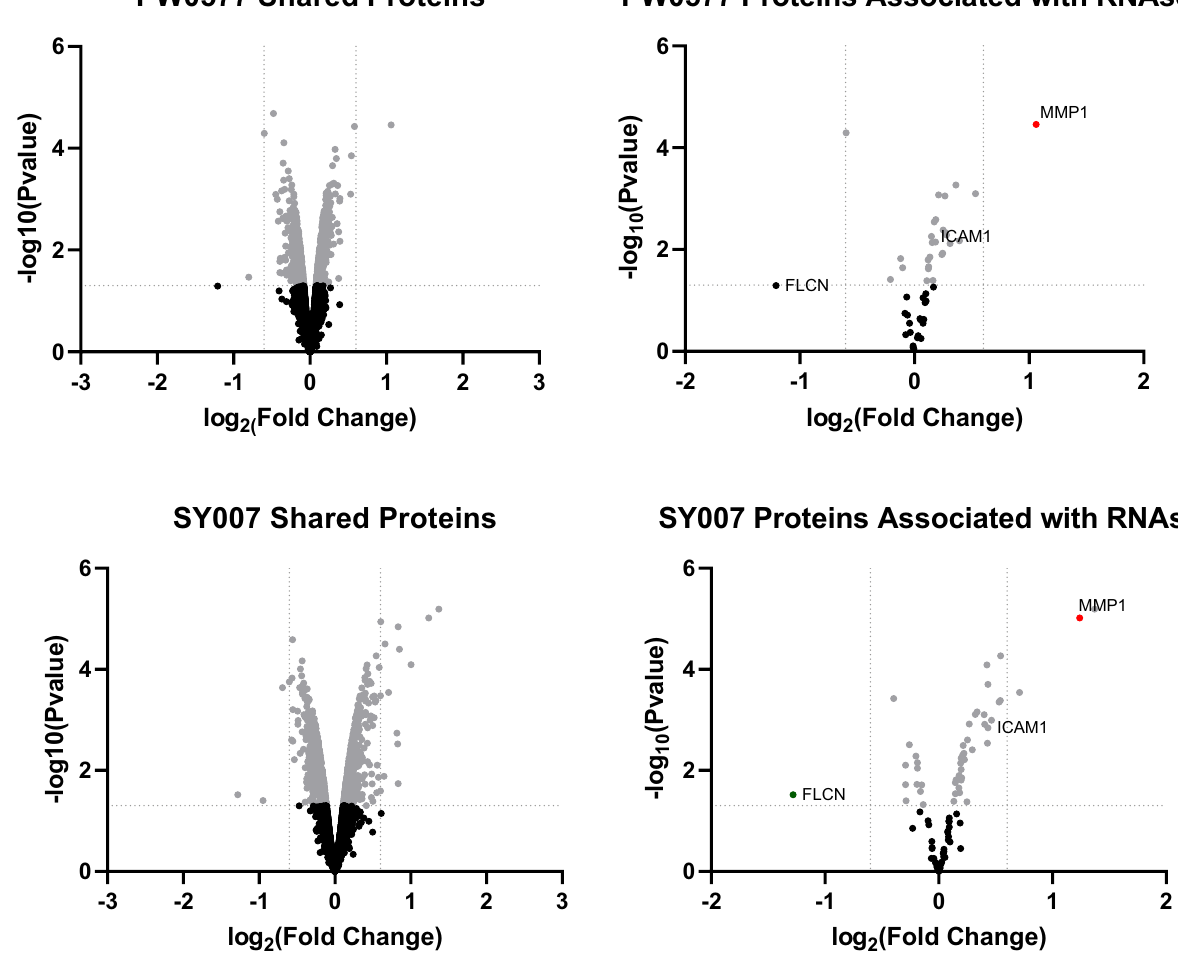
Figure 5. Proteomic Analysis of HUVECs stimulated with either PWO577 or SY007. HUVECs were stimulated for 16 h with either PWO577 or SY007 and then cell pellets were prepared. Protein extraction was then carried out on cell pellets followed by labelling, tryptic digest and analysis by LC–MS as described in “Materials and methods”. 5555 changes in protein expression, following PWO577 (upper left) or SY007 (upper right) treatment, are shown as volcano plots in the left-hand panels. Significant changes in protein expression (p > 0.05) are shown in light grey. Protein expression changes, associated with genes identified in Fig. 4 as being regulated by either PWO577 or SY007, are plotted in the right-hand panels. Significant protein expression changes (p > 0.05) are shown in light grey with changes in protein expression greater than 2-fold indicated either red (increase in gene expression) or green (decrease in gene expression). Non-significant protein changes are shown in